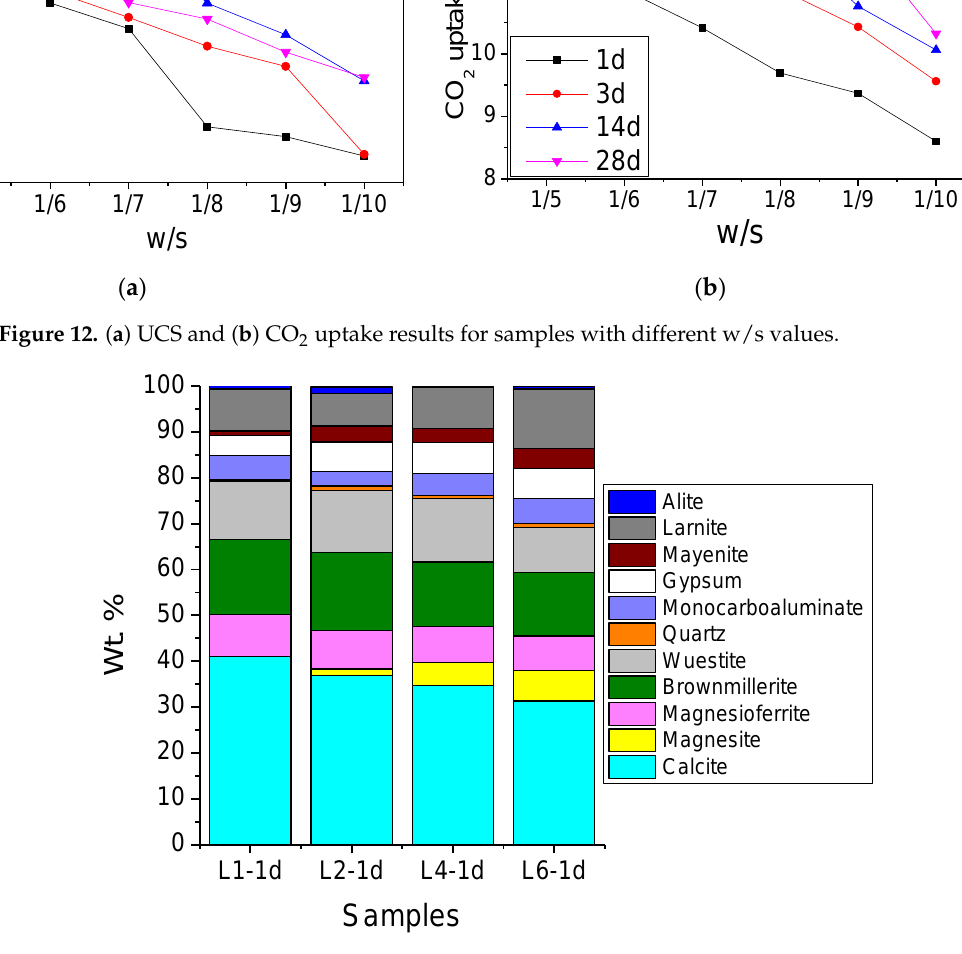
Figure 12. ( a ) UCS and ( b ) CO 2 uptake results for samples with different w/s values.